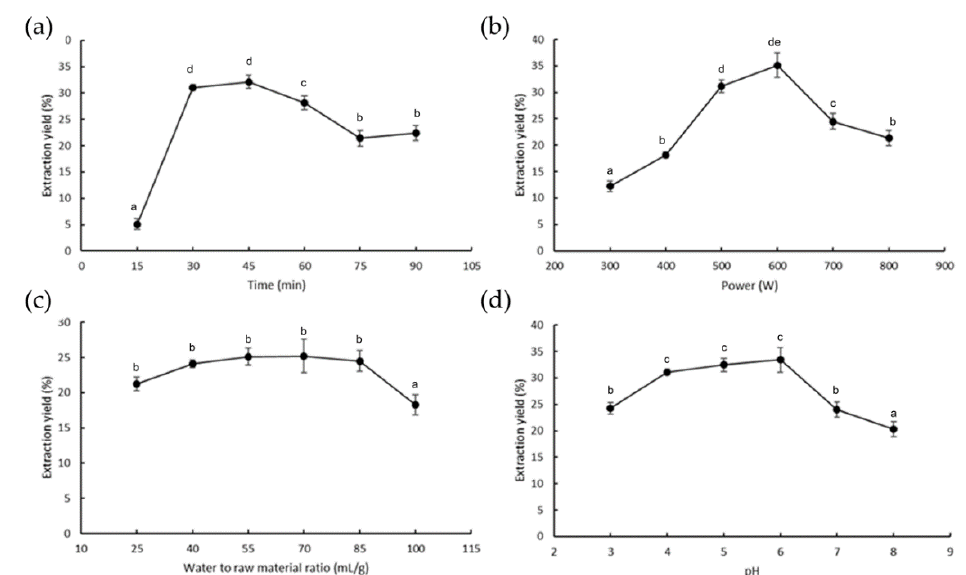
Figure 1. Effect of different times ( a ), powers ( b ), water-to-raw material ratios ( c ), and pH ( d ) on the extraction yield of ulvan. Different letters show statistically significant differences among the groups ( p < 0.05). Table 2. ANOVA of the RSM model for the prediction of ulvan yield. Source Sum of Squares DF Mean Square F Value p -Value